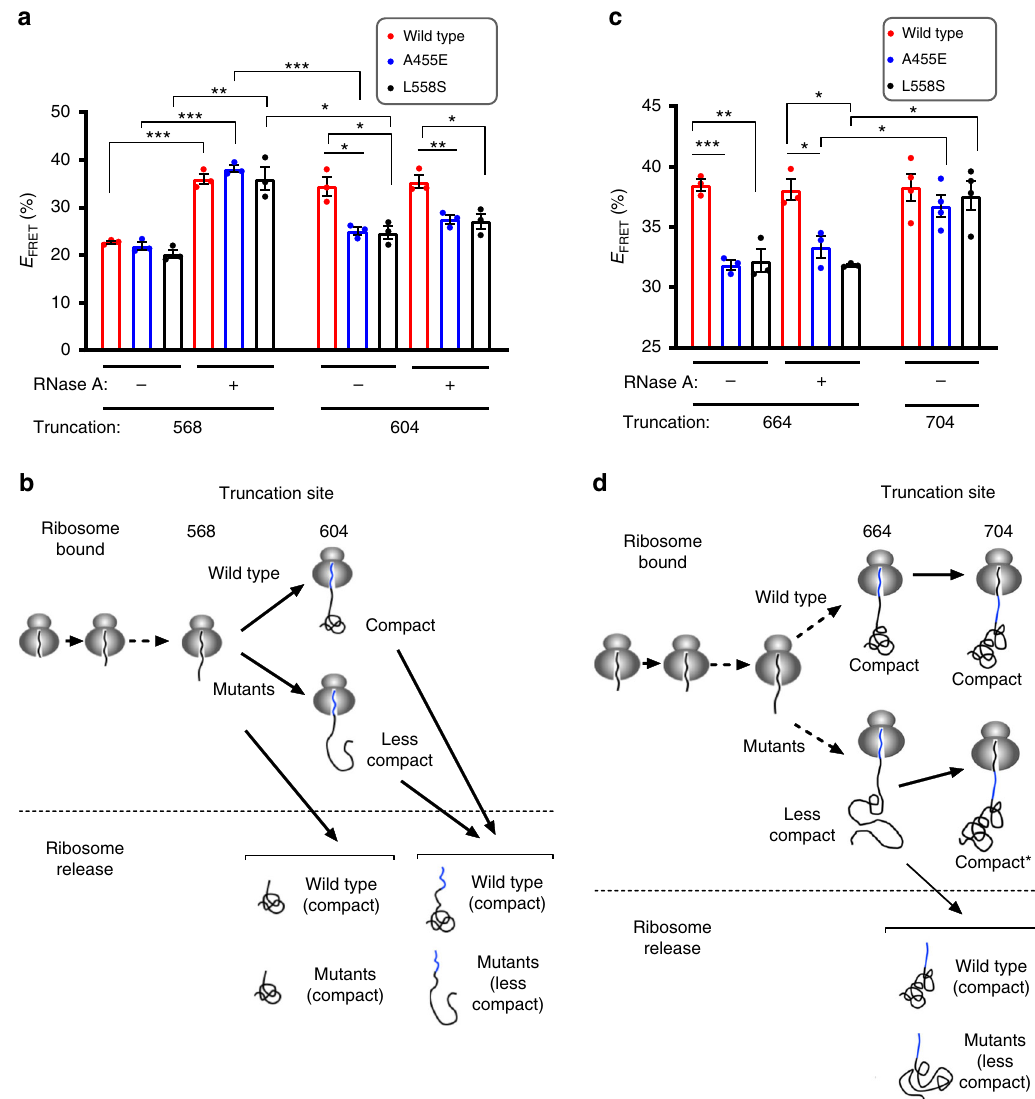
Fig. 3 Ribosome in fl uences cotranslational folding defects. a , c FRET ef fi ciencies of ribosome-bound and released CFP-NBD1± A455E or ± L558S polypeptides (acceptor dye at Arg487) truncated at residue 568 or 604 a , and 664 or 704 c . Each dot represents data from an independent experiment. Each bar shows mean ± SEM, n = 3 or 4 independent experiments. Two-tailed student ’ s t test, asterisk p < 0.05, double asterisk p < 0.01, triple asterisk p < 0.001, n.s. > 0.05 otherwise indicated. Ribosome-released (RNase A) (truncation 568 or 664) and ribosome-bound (truncation 604 or 704) polypeptides contains equivalent cytosolically exposed residues, therefore differences in FRET are due to ribosome attachment. b , d Illustration depicting results of a , or c showing schematic of wild-type and mutant ribosome-bound and released polypeptides (acceptor dye at Arg487) truncated at indicated residue. b NBD1 polypeptides truncated at residue 568 remain unfolded on the ribosome and show an increase in FRET, consistent with α -helical subdomain folding, following ribosome release. Wild-type ribosome-bound and released polypeptides are in the compact sate (high FRET) at truncation 604, whereas mutant polypeptides remain less compact (low FRET) both before and after ribosome release. d Wild-type ribosome-bound and released polypeptides are shown in the compact sate at truncation 664, whereas mutant polypeptides remain less compact (low FRET) both before and after ribosome release. In contrast, both wild-type and mutant polypeptides truncated at residue 704 have achieved a compact state (high FRET). Source data of a and b are provided as a Source Data fi